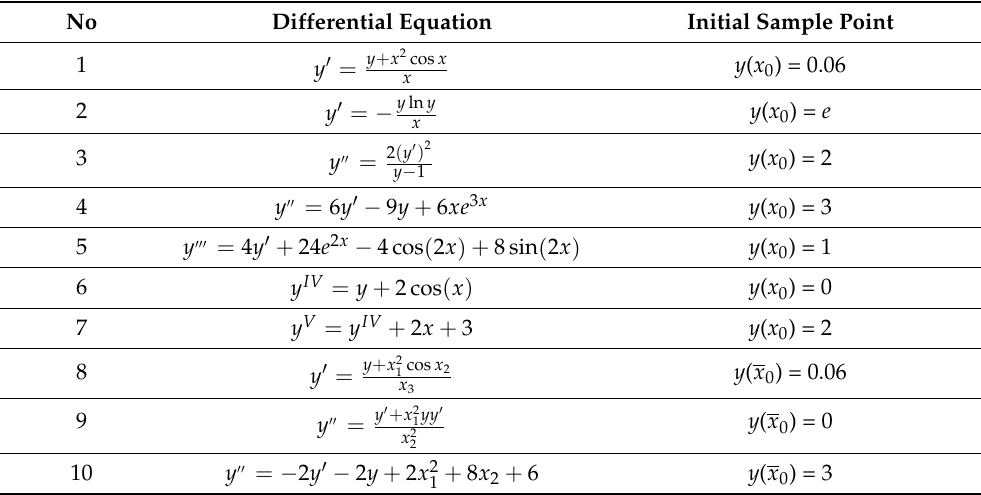
Table 1. Test tasks for the evolutionary approach to the identification of dynamical systems in the form of an